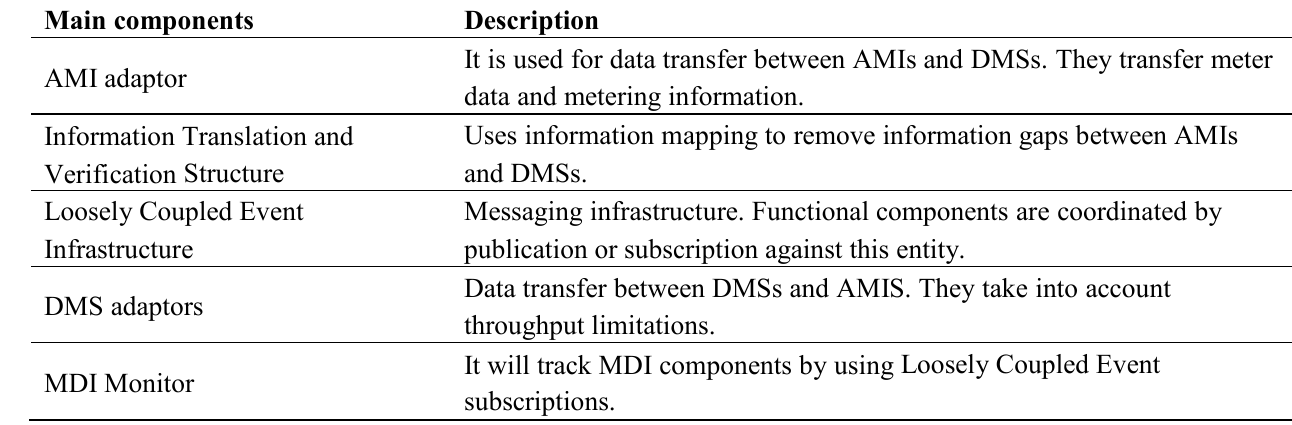
Table 5. Description of MDI main